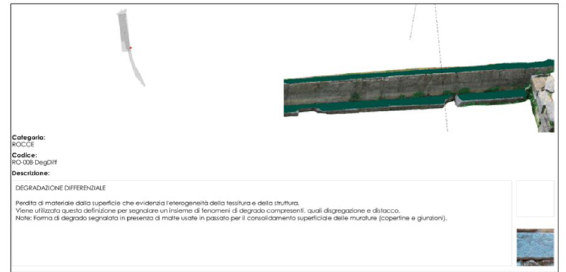
Figure 10. Portion of a PDF report automatically generated by EasyCUBE PRO (informative data)